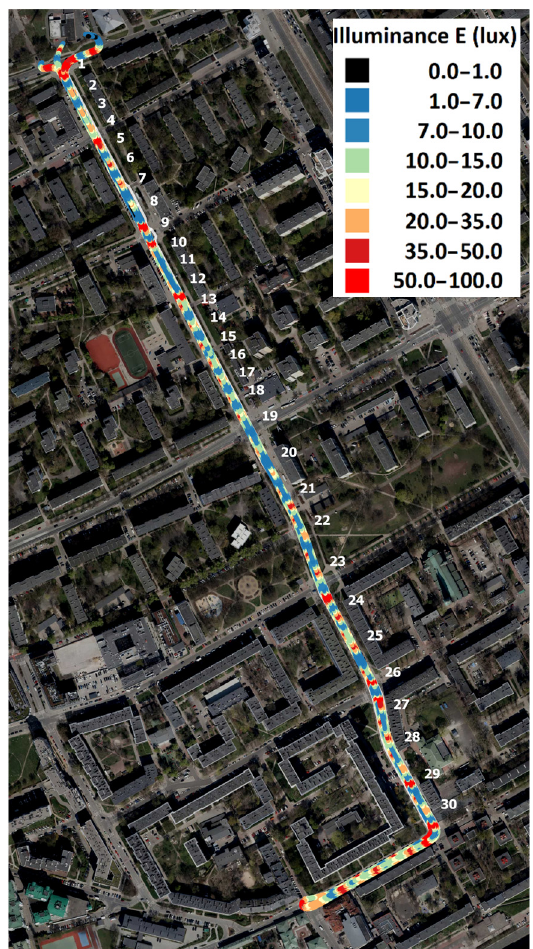
Figure 12. Illumination intensity map recorded with the geolocated GPS RTK measurement system along the entire section of Smocza Street, with the measurement field numbers marked.